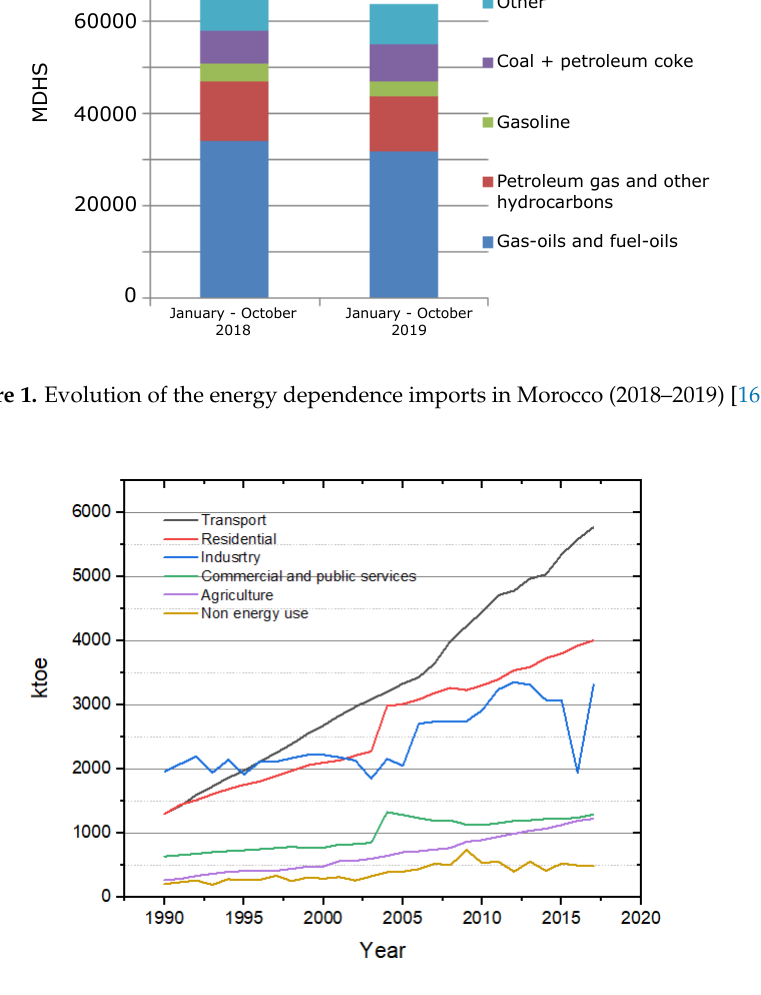
Figure 2. Energy consumption evolution in Morocco by sectors (1990–2020)